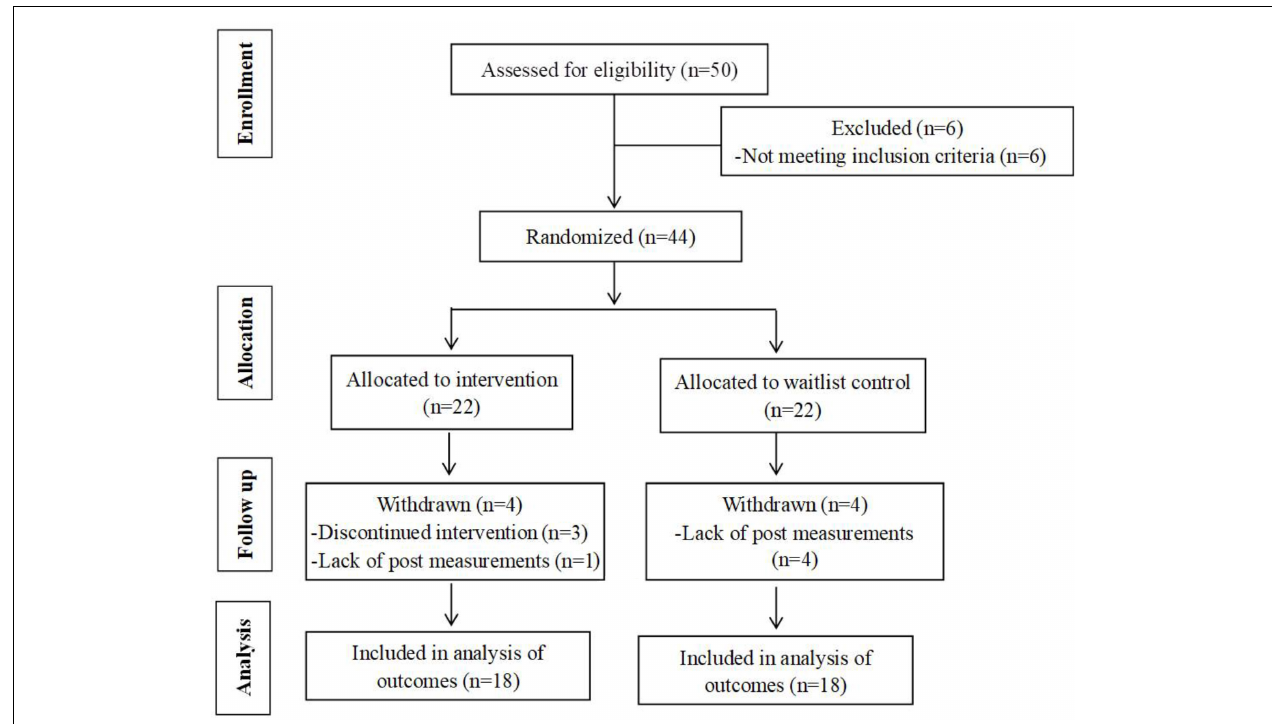
FIGURE 1 | Summary of the participant-flow